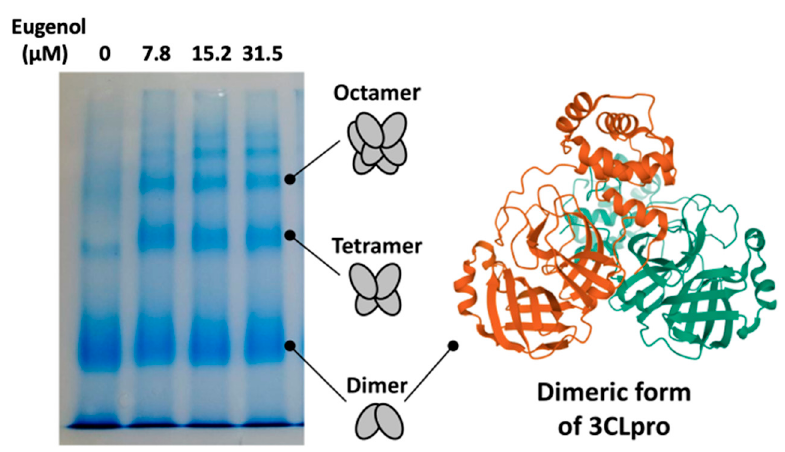
Figure 4. Native polyacrylamide gel electrophoresis (PAGE) showing the effect of eugenol on 3CLpro quaternary structure. The lanes correspond to eugenol concentrations of 0, 7.8, 15.2, and 31.5 µ M (from left to right).